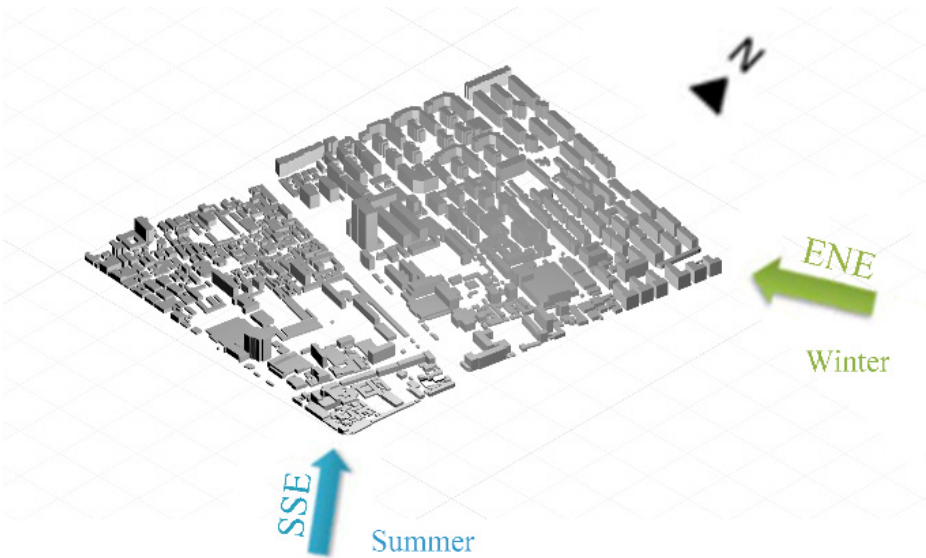
Figure 4. Direction of the winds in the study region.